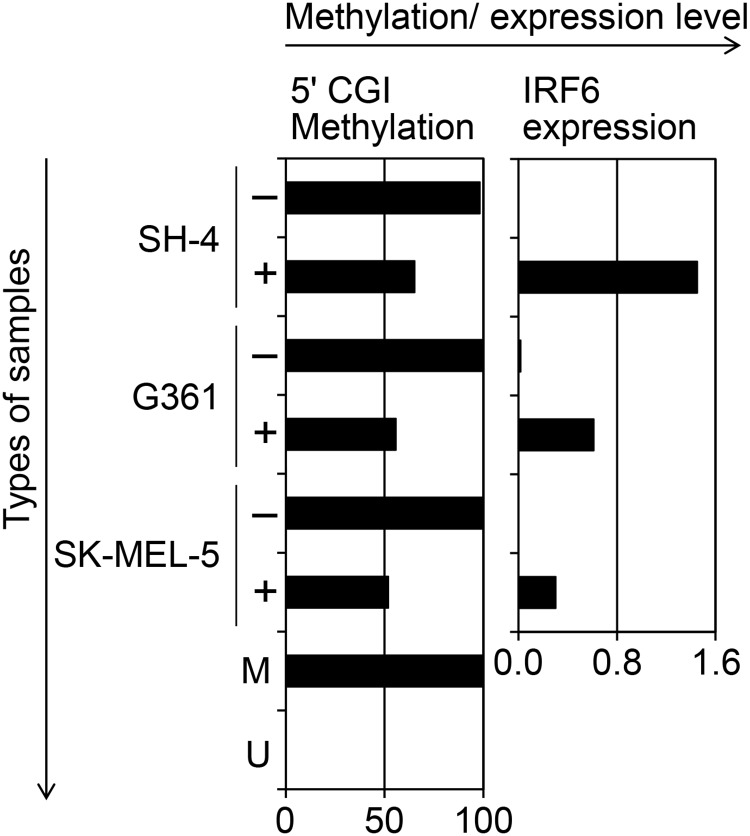
Transcriptional induction of IRF6 in SH-4, G-361 and SK-MEL-5 cells after treatment with the demethylating agent 5-aza-dC.The left bar graph indicates the methylation levels (%) of the 5' IRF6 CGI and the right bar graph indicates the expression levels of IRF6 divided by those of GAPDH (×10−4), in SH-4, G-361 and SK-MEL-5 cells that were treated with the demethylating agent (+) or with PBS (-). Both bar graphs correspond to each other with respect to the cell lines.